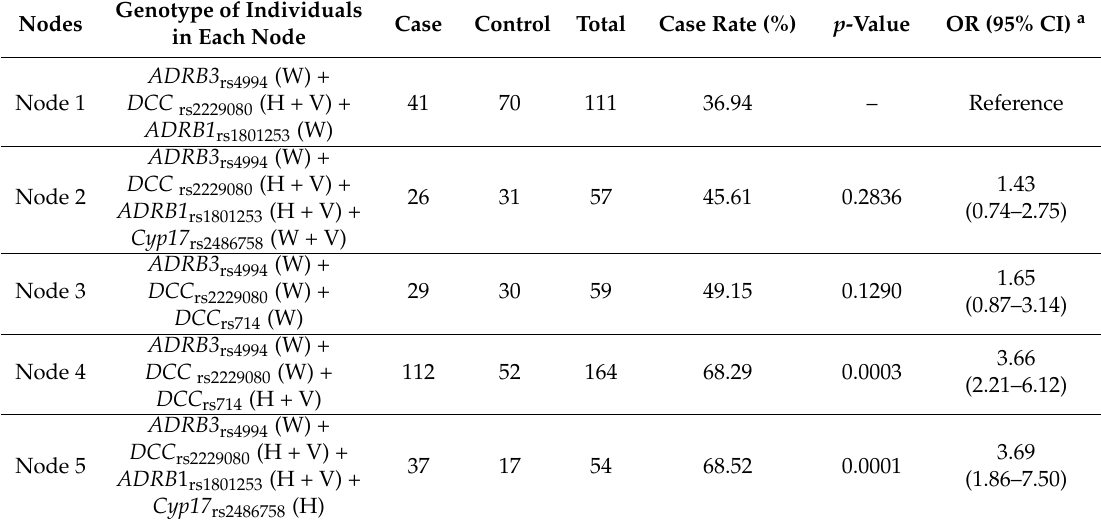
Case rate: Percentage of cancer patients among all individuals in each node (case/(case + control) ˆ 100); a Adjusted for age and gender.